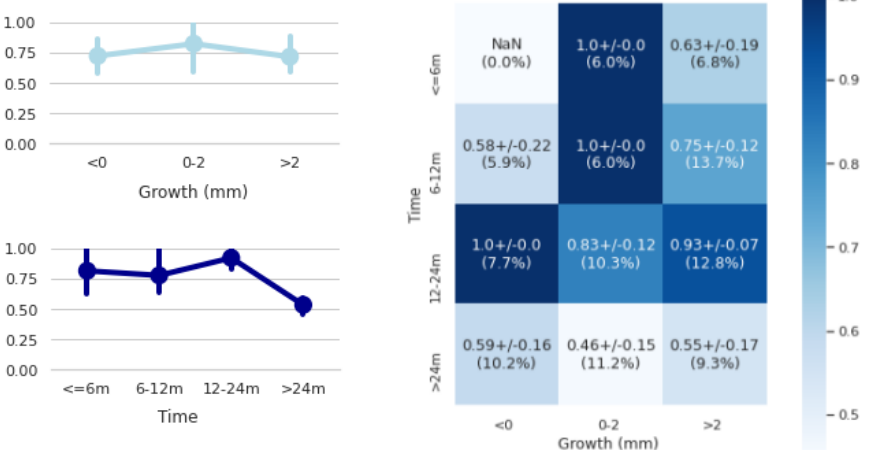
Figure 7. Tumour growth performances of the U-HPNet stratified by nodule growth sizes (top- left), by time to predict (bottom-left) and by both factors (on the right) using the closest ground truth criterion. In each cell of the confusion matrix, we show the accuracy and, in parentheses, the percentage of cases of the test set. The NaN means that there were no data in the test set for this combination.